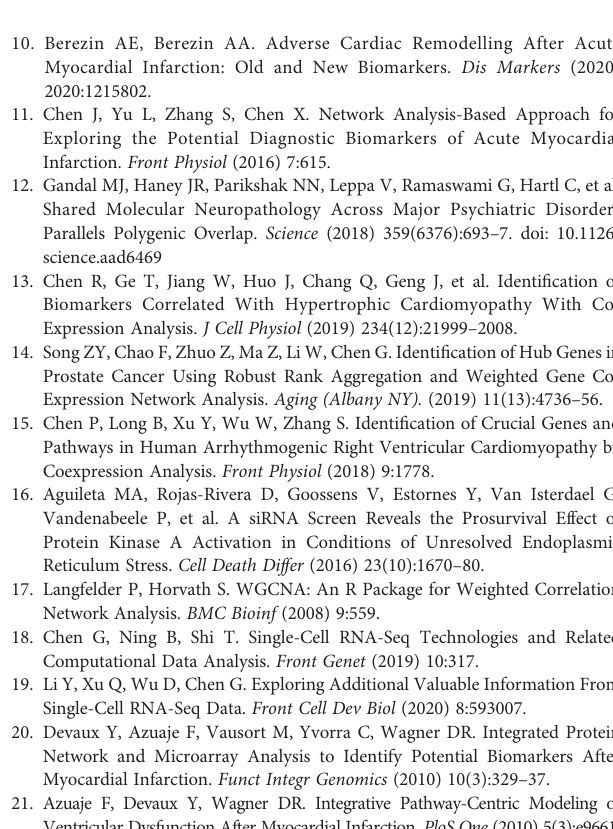
Supplementary Table 1 | Demographic characteristics of post-AMI HF (n=9) and non-HF (n=8) patients from dataset GSE59867. Supplementary Table 2 | Genes of greenyellow module. Supplementary Table 3 | GO biological processes in greenyellow module. Supplementary Table 4 | Pathways analyses in greenyellow module. Supplementary Table 5 | Hub genes of greenyellow module. Supplementary Table 6 | Overlapped genes between GSE11947 and GSE59867. Supplementary Table 7 | Markers of Monocytes/Macrophages 2 days after AMI and Markers of Monocytes/Macrophages and Neutrophils 3 days after AMI.